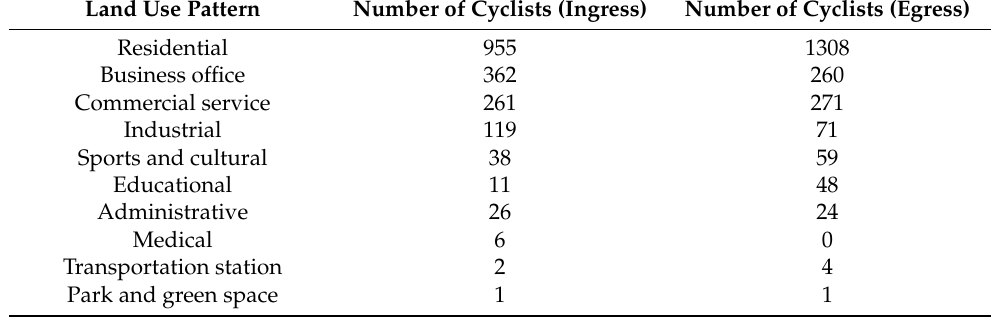
Table 6. Travel behavior of transit by bicycle-sharing.